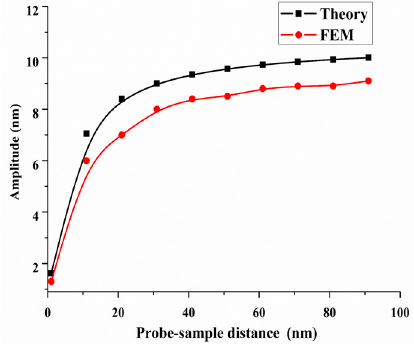
Figure 17. Approach curves of the QTF-p under a viscous resistance